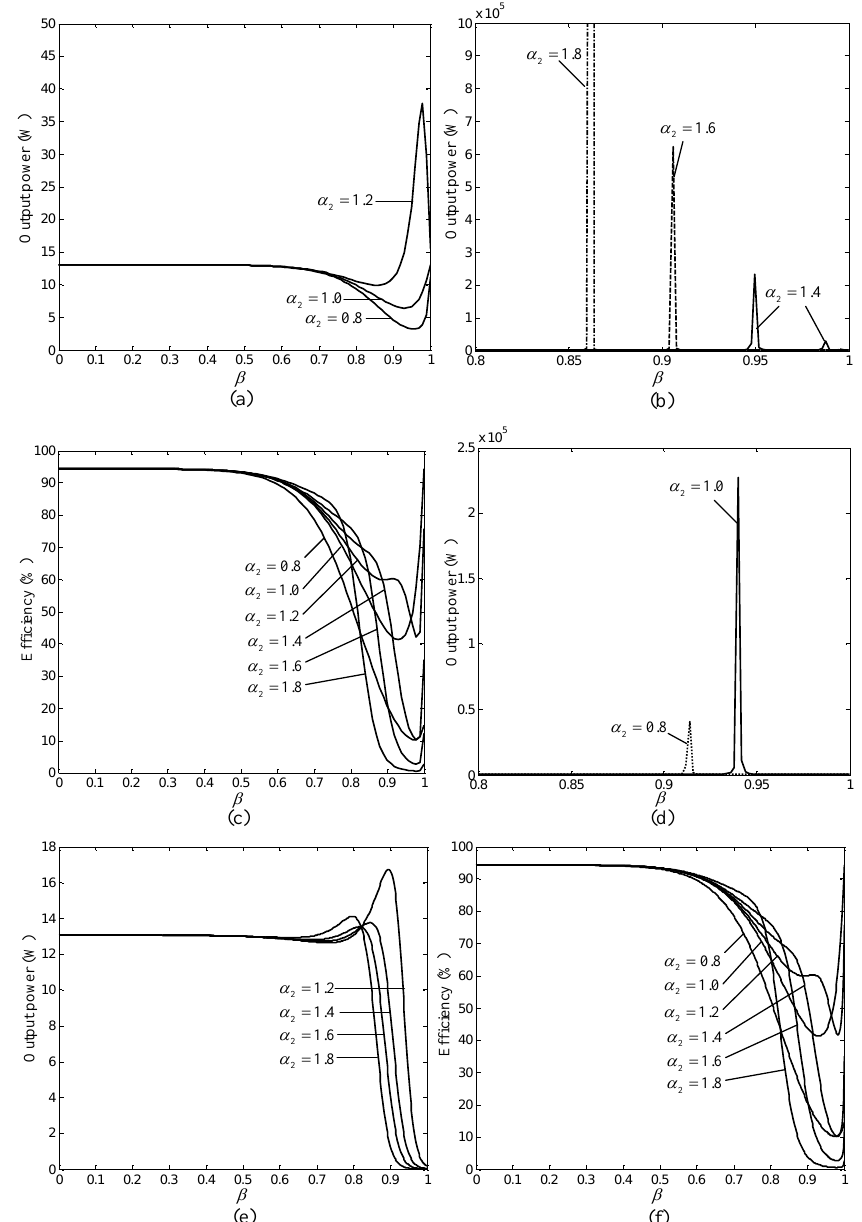
Figure 5. Theoretical curves of output power and transmission efficiency as a function of fractional order β when 1 ≤ α 1 < 2 and 0.8 ≤ α 2 < 2: ( a ) Output power versus β when α 1 = 1.0 and 0.8 ≤ α 2 ≤ 1.2; ( b ) Output power versus β when α 1 = 1.0 and 1.4 ≤ α 2 < 2; ( c ) Transmission efficiency versus β when α 1 = 1.0 and 0.8 ≤ α 2 < 2; ( d ) Output power versus β when α 1 = 1.2 and 0.8 ≤ α 2 ≤ 1.2; ( e ) Output power versus β when α 1 = 1.2 and 1.2 ≤ α 2 < 2; ( f ) Transmission efficiency versus β when α 1 = 1.2 and 0.8 ≤ α 2 < 2.